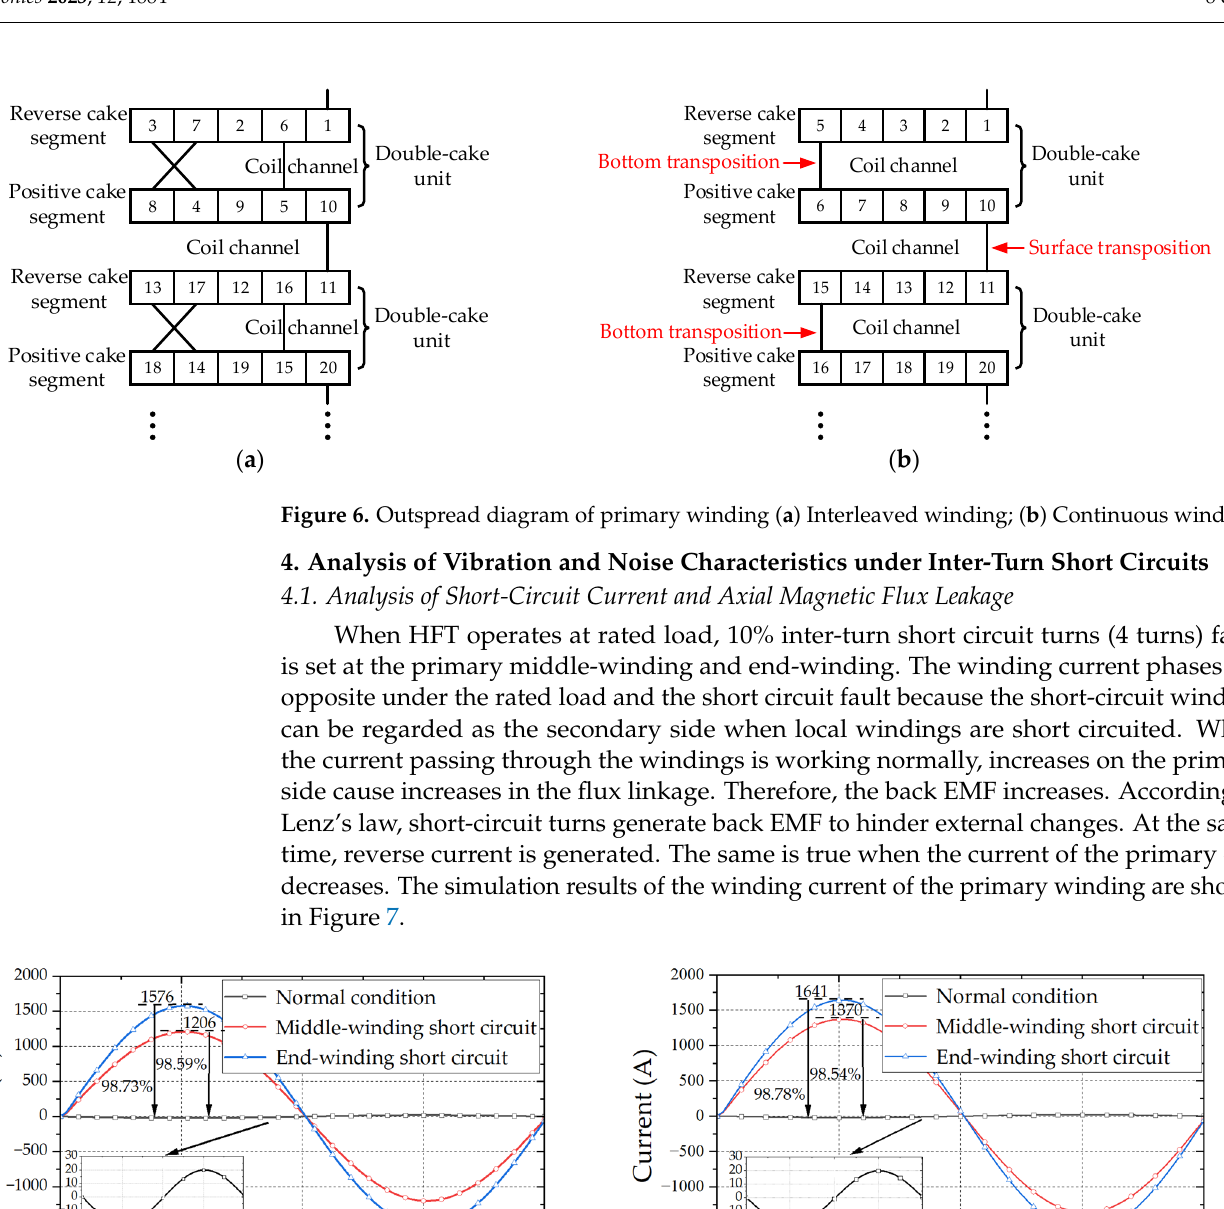
Figure 7. Rated and short-circuit current of primary winding ( a ) Interleaved winding; ( b ) Continu- ous winding.